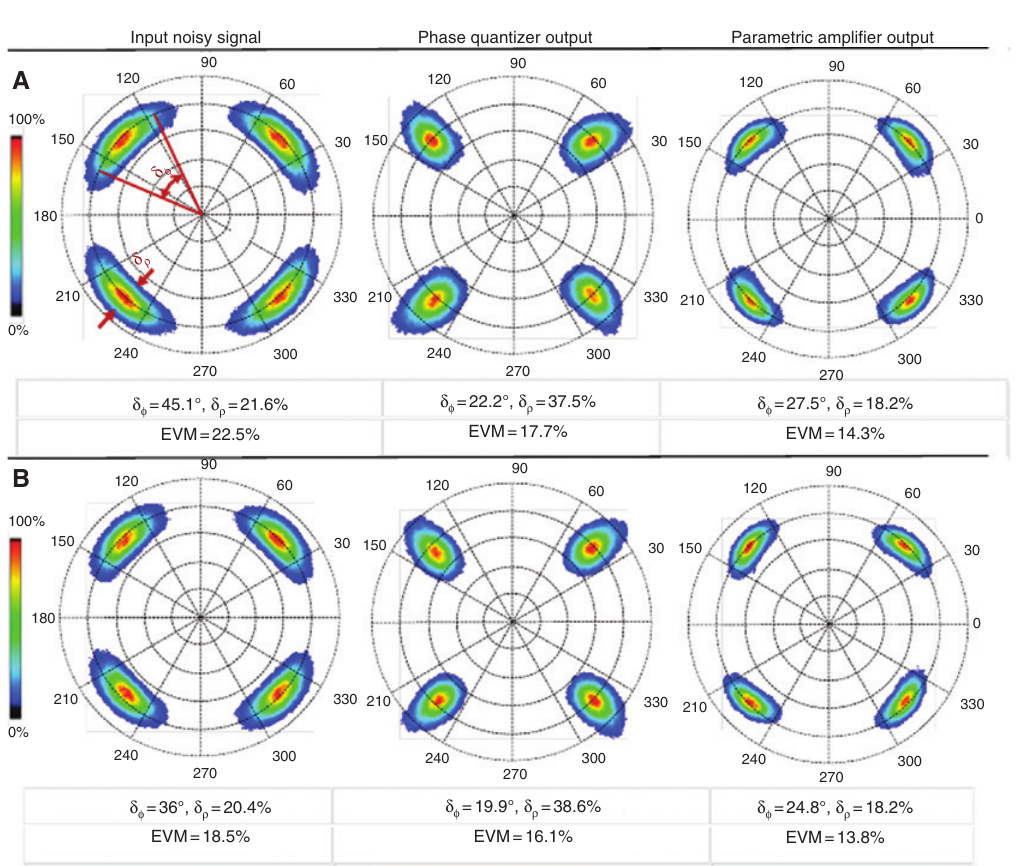
Figure 27: Saturation amplification